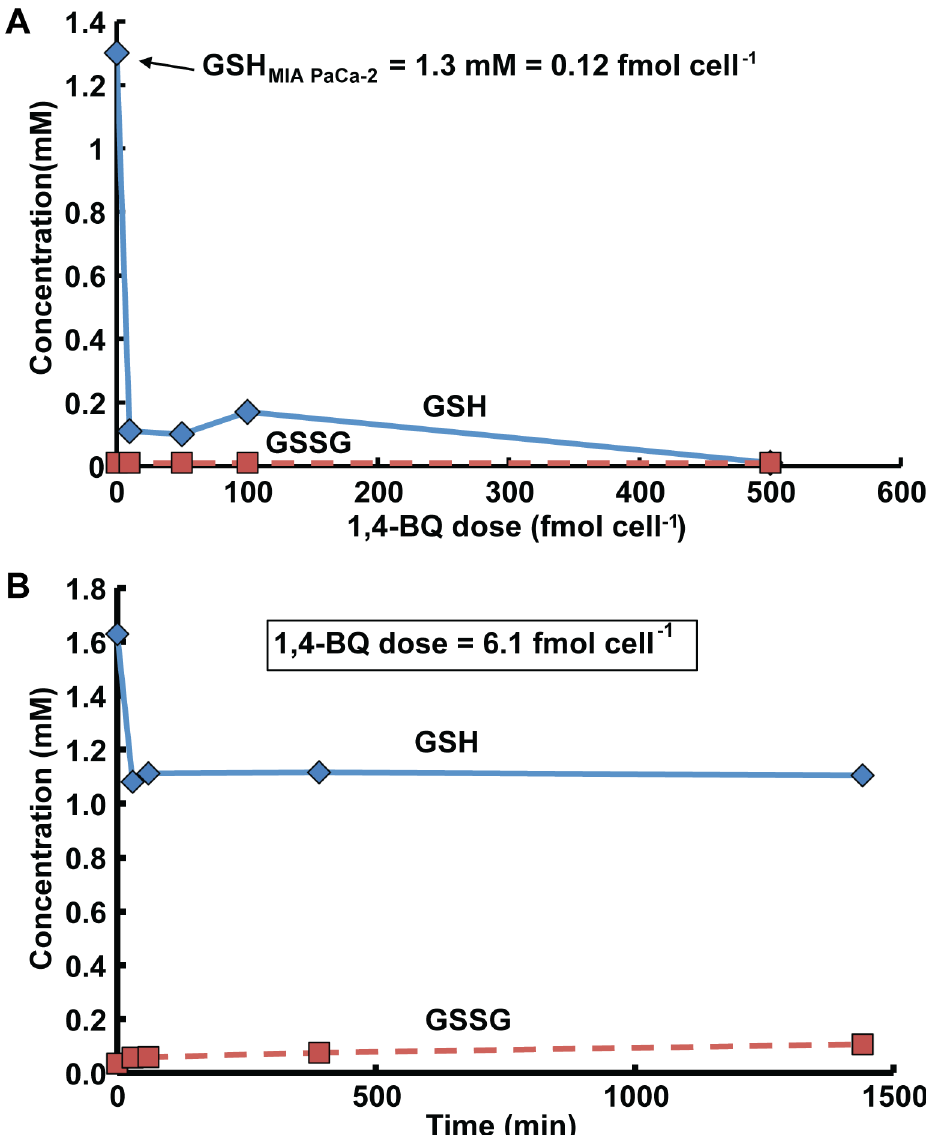
Fig 6. Glutathione is not depleted with 1:1 stoichiometry upon exposure of MIA PaCa-2 cells to 1,4-BQ. (A) Intracellular concentration of GSH and GSSG in MIA PaCa-2 cells after a 30-min exposure to different doses of 1,4-BQ. The basal level of GSH in MIA PaCa-2 cell is 0.12 fmol cell -1 or 1.3 mM, assuming a uniform intracellular distribution and an intracellular volume of 2.03 pL cell -1 , Table 1. To deplete 90% of the basal intracellular GSH a large excess of 1,4-BQ (10 fmol cell -1 ) is required. Additional depletion up to 99% requires (cid:1) 400 fold excess of 1,4-BQ. This implies that 1,4-BQ most likely reacts with extracellular targets; the fraction that enters the cells reacts with the multitude of targets available in the intracellular space. GSSG is not significantly produced (statistically) in these experiments. (B) Intracellular concentration of GSH and GSSG up to 24 h after exposure to a bolus of 1,4-BQ. Following exposure of MIA PaCa-2 cells to 1,4-BQ (6.1 fmol cell -1 ), an immediate 31% depletion in GSH levels is observed. There is no recovery of GSH for at least 24 h after exposure. There is little generation of GSSG, indicating negligible generation of H 2 O 2 . On a mol cell -1 basis, only 1 out of 100 of the molecules of 1,4-BQ that were present at the start of the exposure reacted with GSH; This demonstrates that GSH is not the exclusive target for 1,4-BQ. Shown here are typical experiment results, n = 3. The coefficient of variation in the GSH and GSSG measurements is